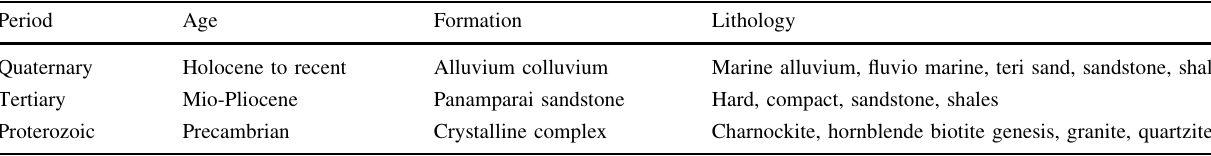
Table 1 The stratigraphic succession in Tuticorin District